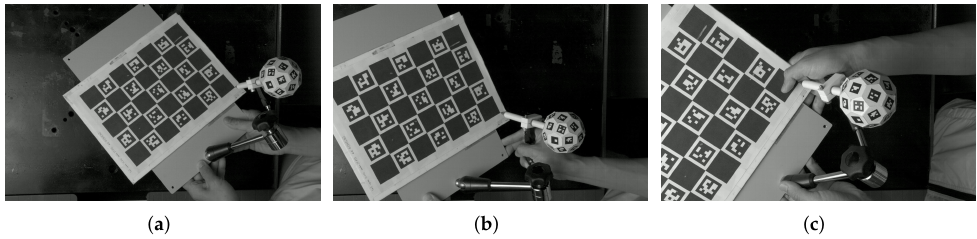
Figure 15. Dynamic experiments of ChArUco board versus Solpen. The setup and some discrete frames ( a – c ).